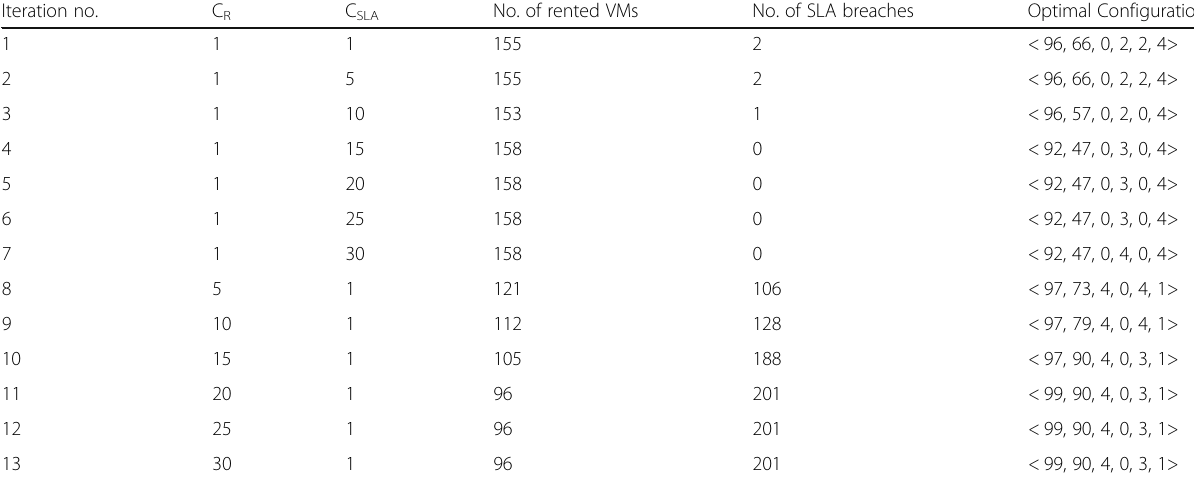
Table 19 The genetic algorithm behavior in an environment with the unpredictable workload Iteration no. C R C SLA No. of rented